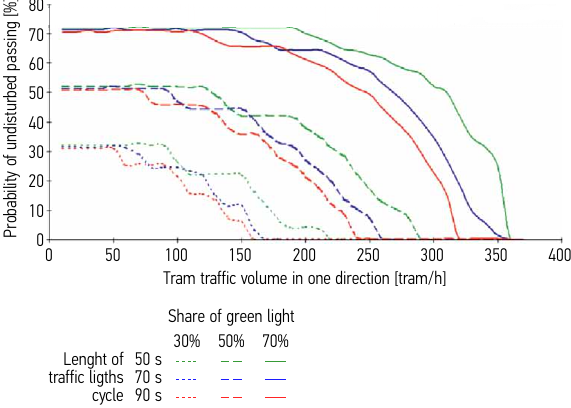
Fig. 9. Probability of undisturbed passing at the traffic lights